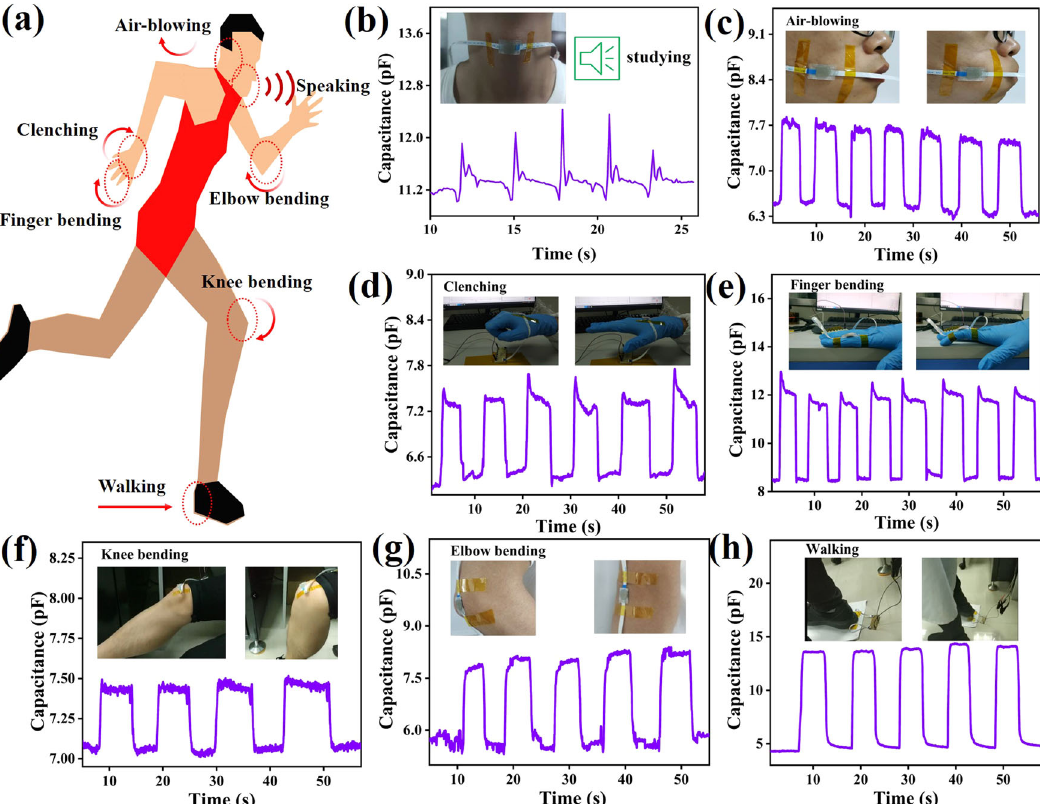
Fig. 5 Demonstration of the micro-structured sensor in response to human activities. a Schematic diagram of the sensor that detects human physiological signals and body motions; b Detection of the vocal cord vibration signal sent from the pronunciation of the word “ studying ” ; c – h The capacitance responses come from the repeated air blowing, clenching and releasing of fi nger/knee/elbow bending, and